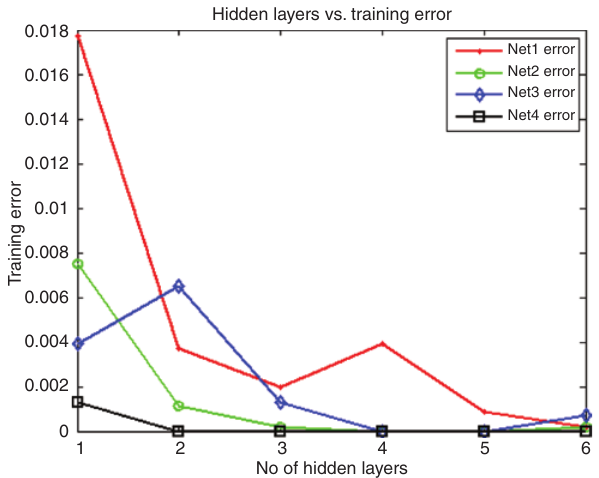
Figure 8: Training Errors for net1, net2, net3, and net4 for Hidden Layers 1 to 6.